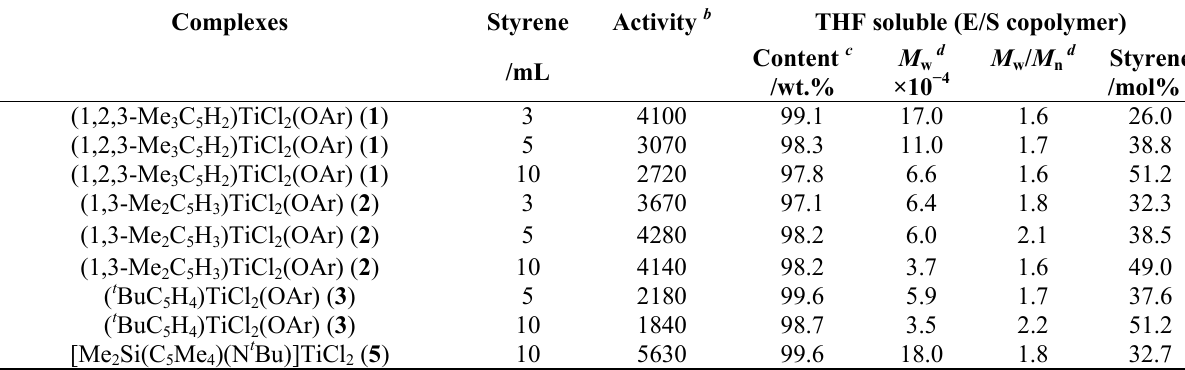
(OAr) [Cp’ = 1,2,3-Me 2